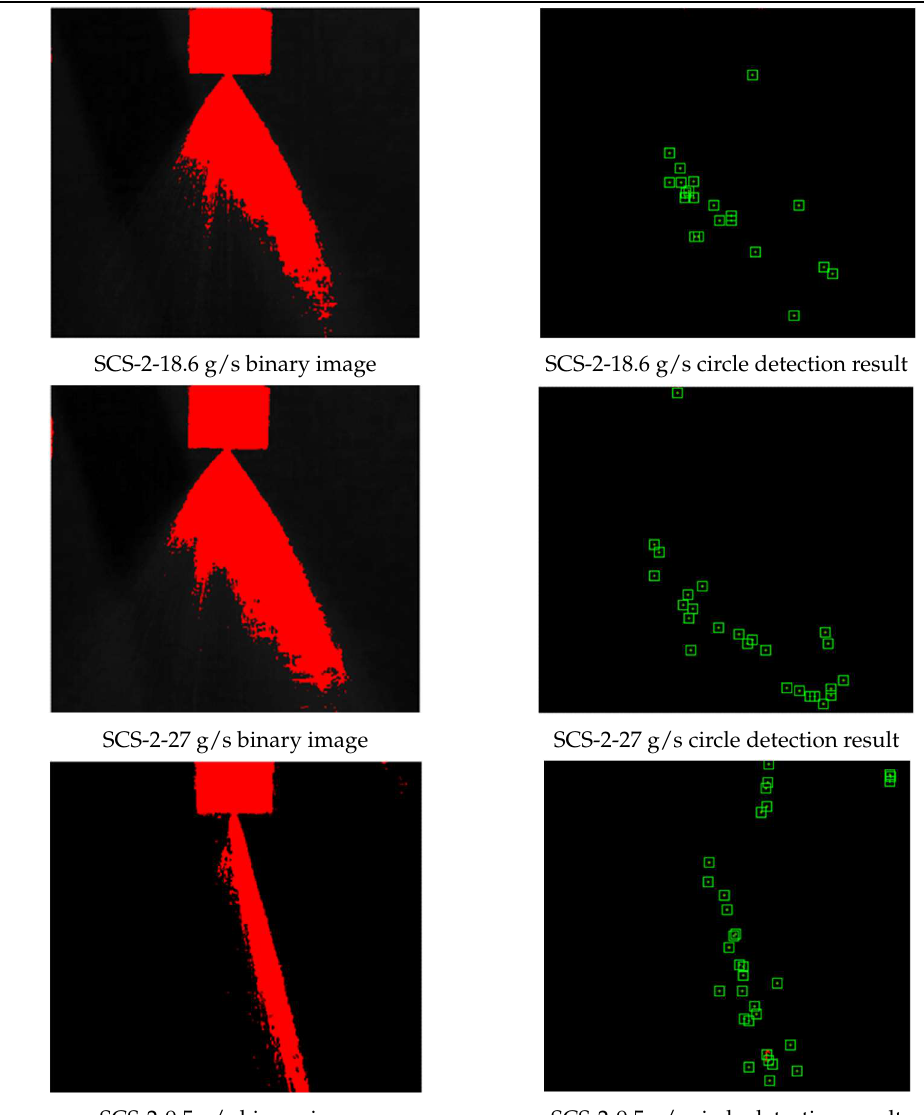
Table 8. Limitations of high-speed photography in particle size measurement.